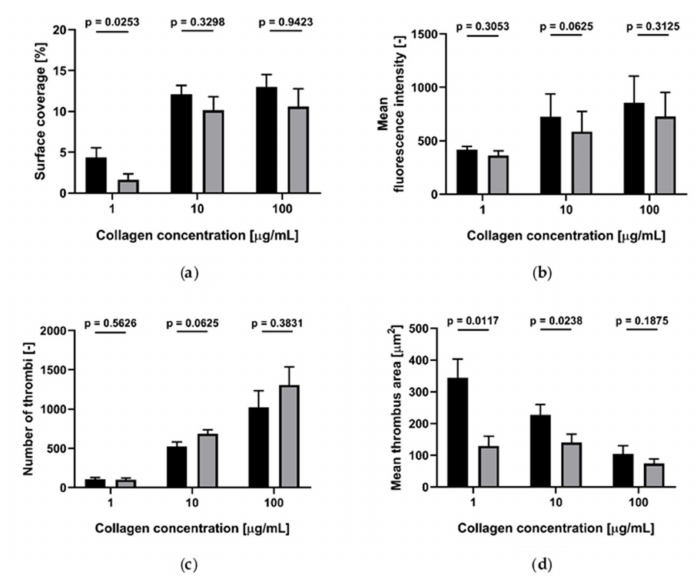
Figure 5. ASA inhibition of platelet accumulation at 300 / s for di ff erent collagen concentrations ( n = 5). Black: without ASA; grey: with ASA added in vitro. ( a ) Surface coverage; ( b ) mean fluorescence intensity: ( c ) number of thrombi; ( d ) mean thrombus area. Data are represented as column bar graphs, with means ± standard errors of the mean, and analyzed by Wilcoxon tests or t-tests as appropriate.